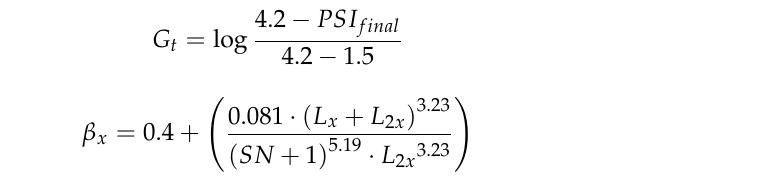
Table 6 lists the data for calculation of N 18 : the sum of values listed in column N 18, x is equal to N 18 . Table 6. Data for calculation of N 18